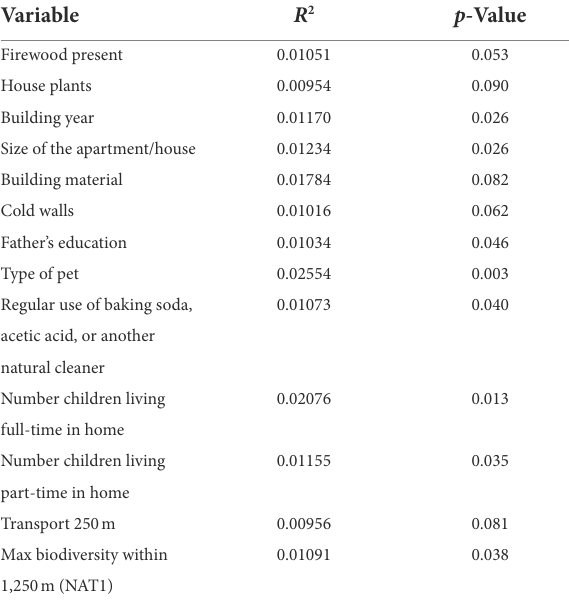
TABLE 1 Multivariate analysis of variance results ( R 2 and value of p ) for bacterial associations at the species-level. Variable R 2 p -Value